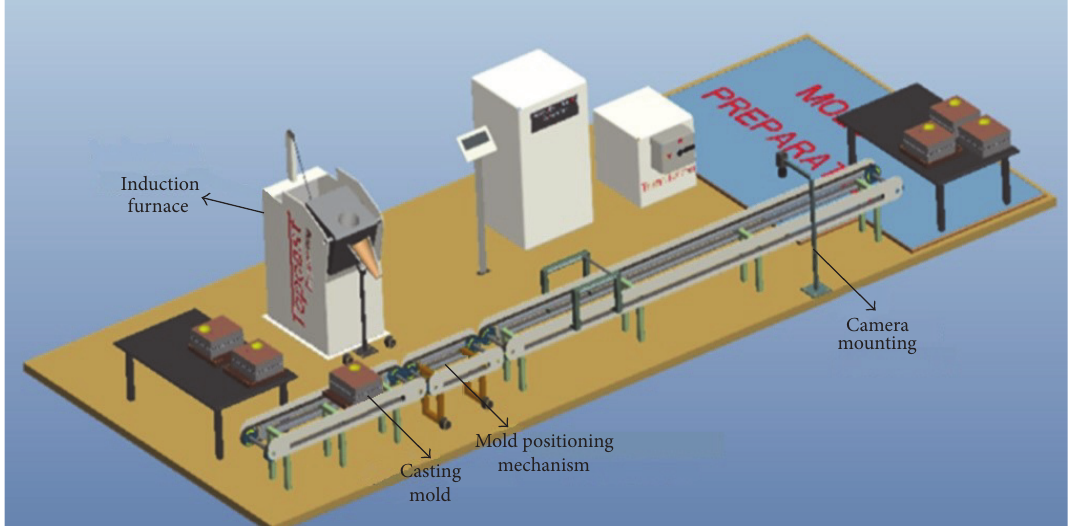
Figure 7: System model for automated sand